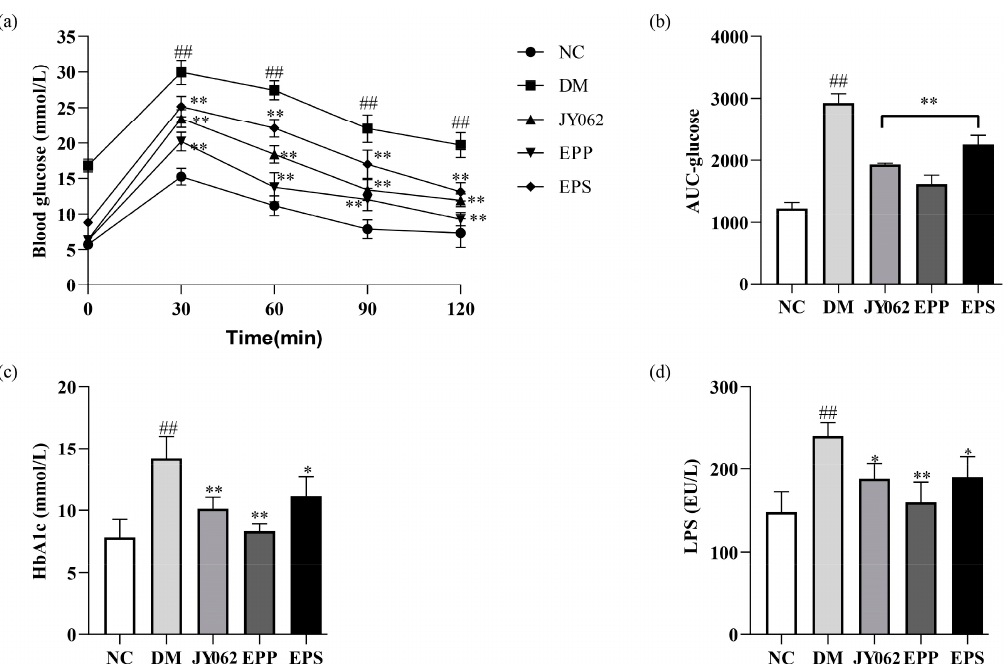
Figure 3. Effects of the dietary intervention on the biochemical parameters. ( a ) The glucose tolerance test (blood glucose values for 0 − 120 min); ( b ) area under the curve (AUC) values; ( c , d ) the levels of HbA1c and LPS were determined by ELISA kits. Data are presented as mean ± SD values. ## p < 0.01 vs. NC group; * p < 0.05, ** p < 0.01 vs. DM group.